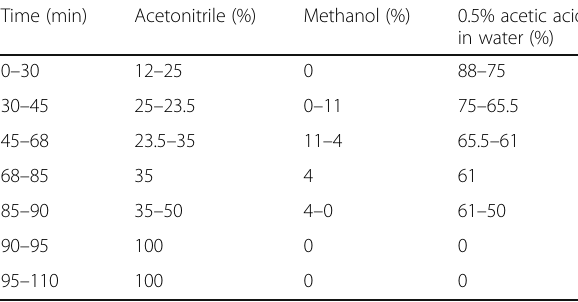
Table 1 Mobile phase condition of chromatographic